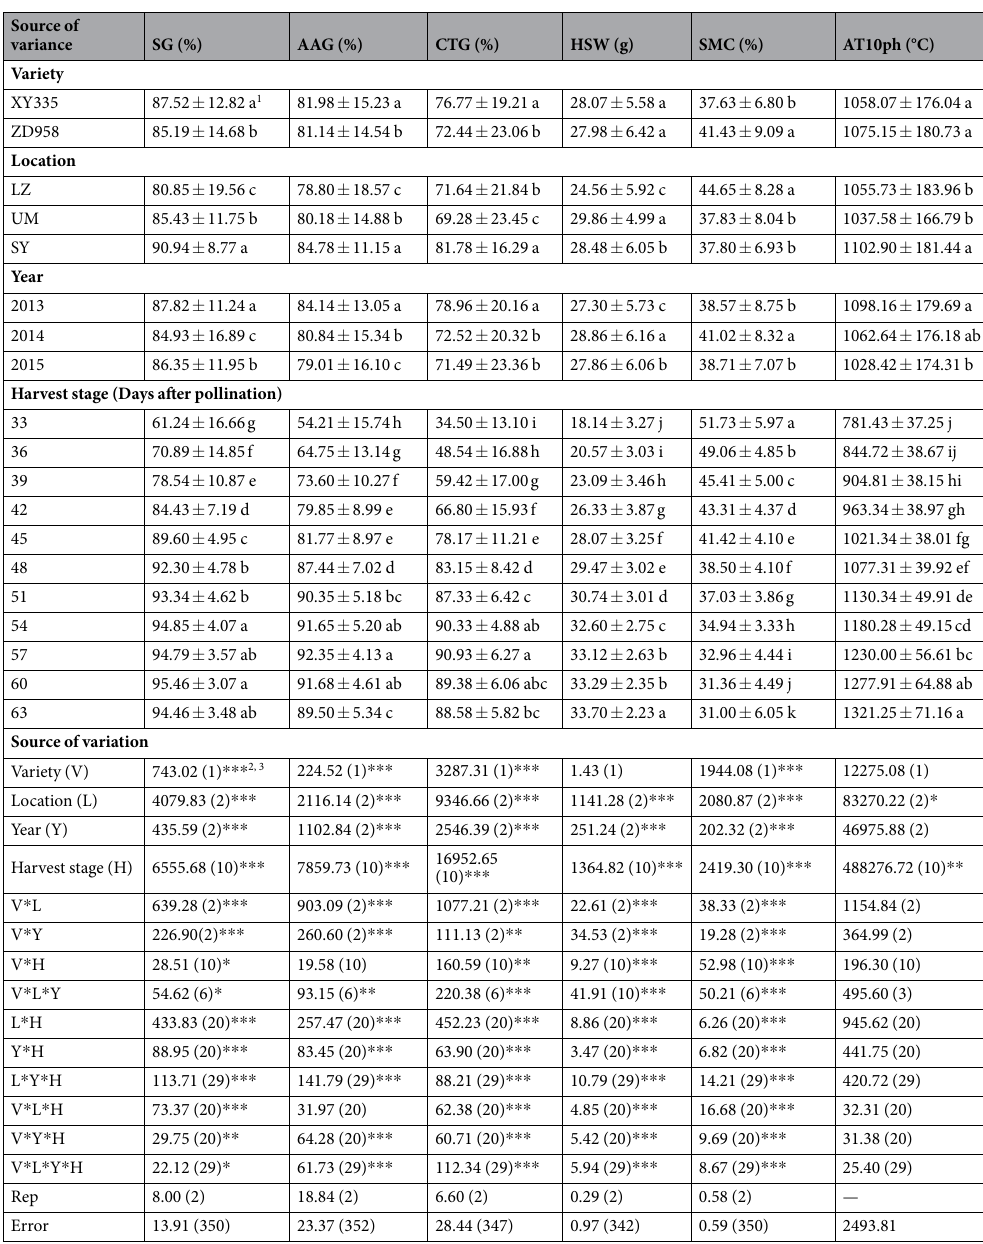
Table 2. Performance and ANOVA of six seed-related traits collected in seeds from Lanzhou (LZ), Urumqi (UM) and Shenyang (SY) over 2–3 years (2013, 2014, and 2015). Seeds were harvested at 11 stages from 33 days after pollination (DAP) to 63 DAP to evaluate traits of standard germination (SG), accelerated aging germination (AAG), cold test germination (CTG), hundred seed weight (HSW), seed moisture content (SMC) and ≥ 10 °C accumulated temperature from pollination to harvest (AT10 ph ). 1 The numbers followed by different letters indicate significant differences (P < 0.05) within variety, harvest stage, location or year. 2 The number in parentheses indicates the degrees of freedom (df) for the variance. 3 * , ** and *** following the number represent significance at p ≤ 0.05, p ≤ 0.01 and p ≤ 0.001,